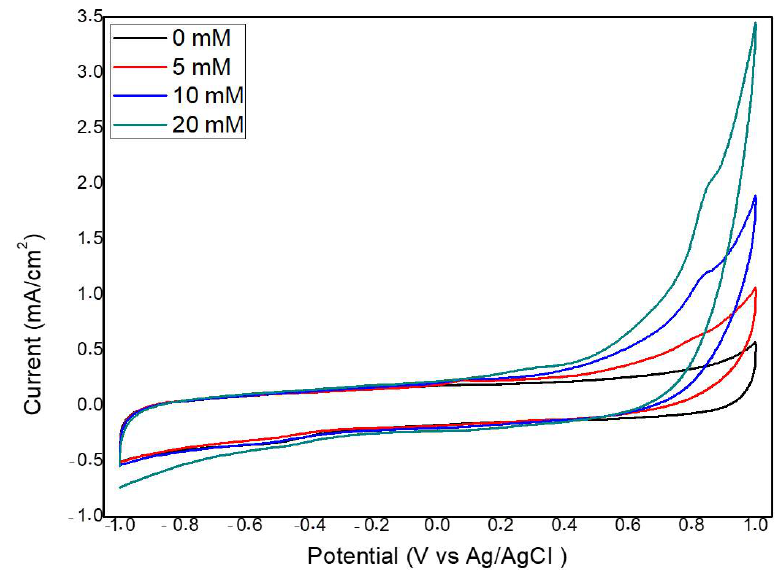
Figure 6. Electrochemical measurements for Mo/CNT at four different molarities.